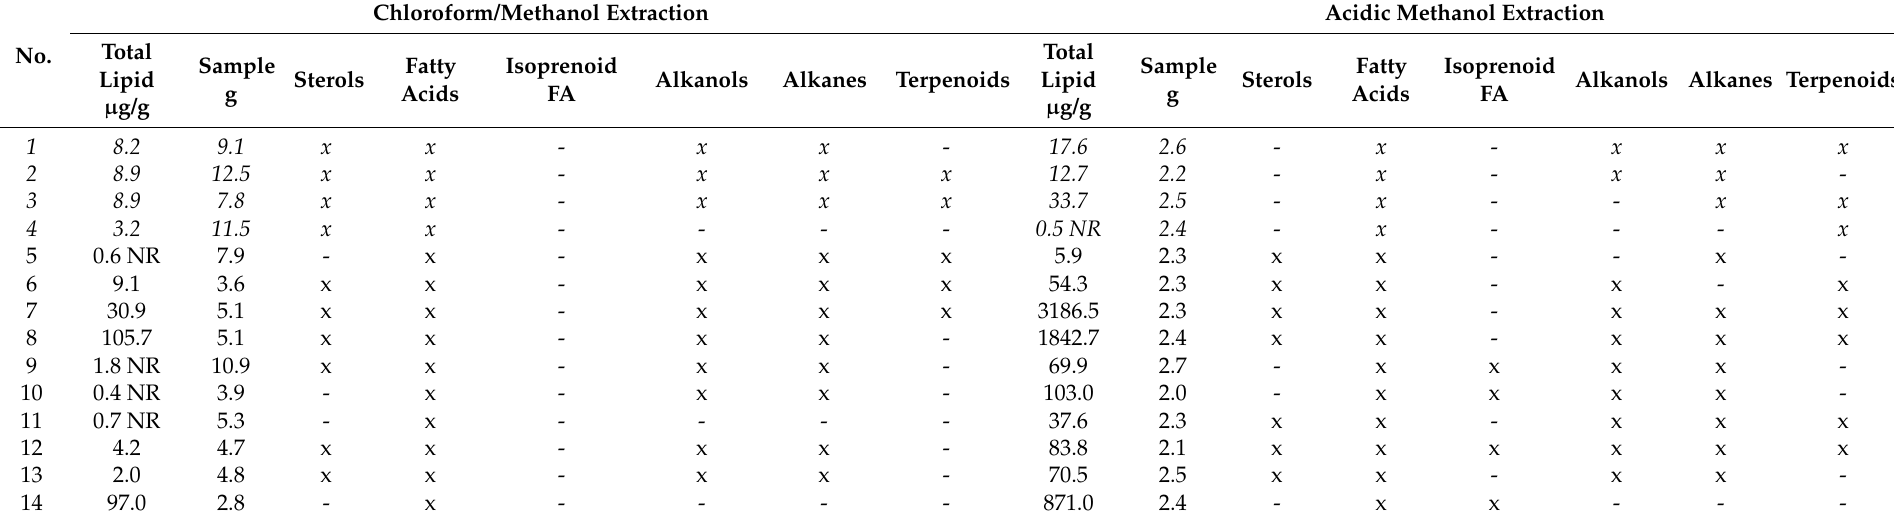
Table 1. Overall residue yield for both extraction methods, with presence/absence of important compound classes. Yield is calculated in µ g lipid per g of sherd, to control for differences in sample size. Pairs sampled at different times are in italics. Samples containing detectable amounts of different compound types are marked with an ‘x’; those without any detectable amounts of these compound types are marked with an ‘-’. Samples containing insufficient residue for interpretation are labelled NR in the total lipid column. Results for samples 1–4 are given in italics, as they were not sampled